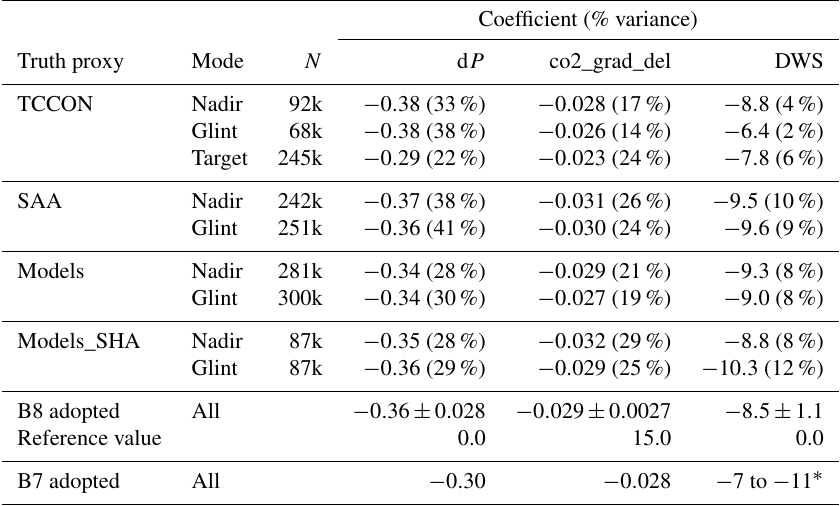
Figure 12. Fraction of L2FP processed soundings passing a quality filter (a, b) and total number of good-quality soundings per month per 6 ◦ × 6 ◦ boxes (c, d) , for the Northern Hemisphere winter (DJF) and summer (JJA). The number plots have a logarithmic color scale, and grid boxes with no data are shown in gray. Table 9. Land bias-correction parameters, their coefficients, and percentage of the variance explained, for different truth proxies and observ- ing